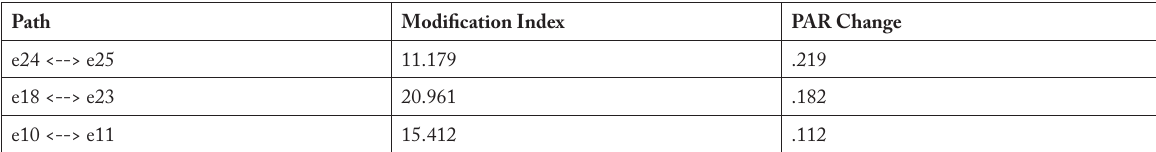
Table 7. Modification of the hypothesized model.